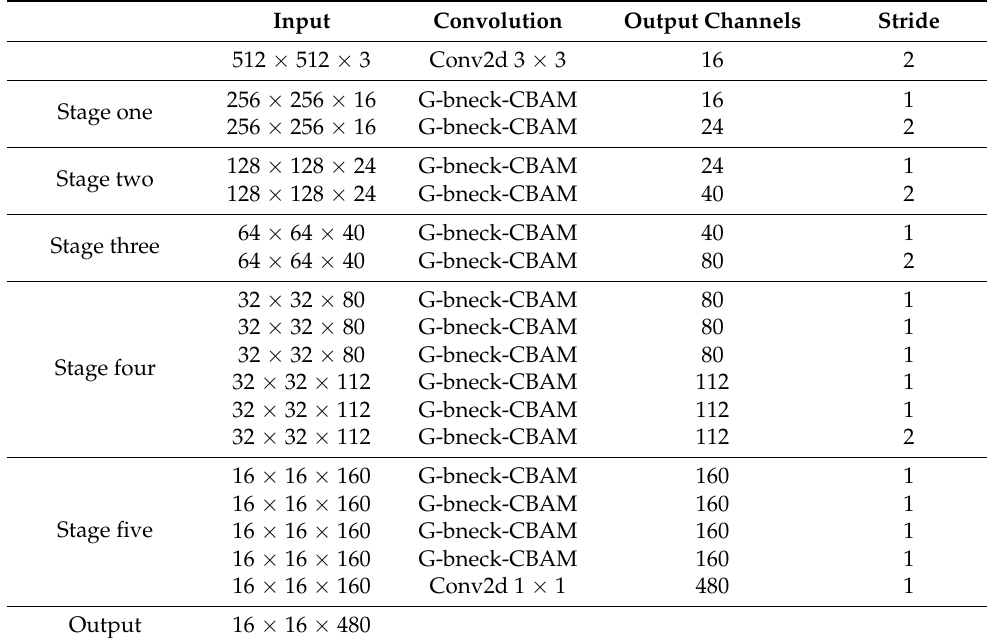
Figure 9. Schematic diagram of the G-Bneck structure introduced into CBAM (G-Bneck-CBAM). Table 1. Parameters in each stage of the CBAM-Mini network backbone feature extraction